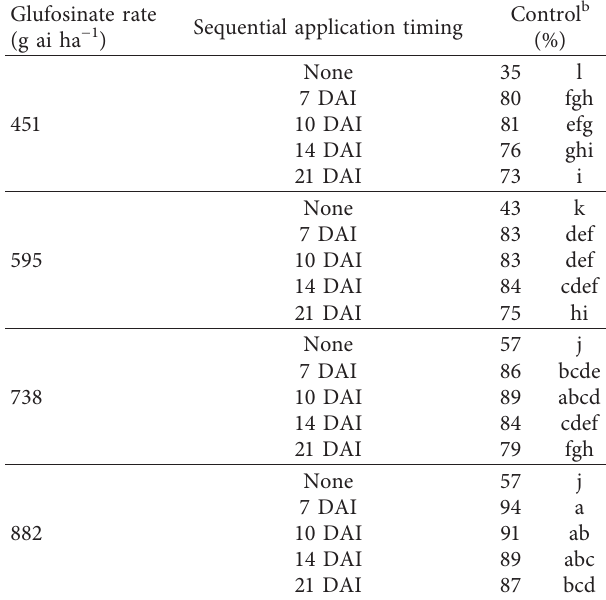
Table 4: Effect of glufosinate rate and sequential application timing on Palmer amaranth control at harvest in Fayetteville, AR, in 2015, 2016, and 2017. Glufosinate rate (g ai ha − 1